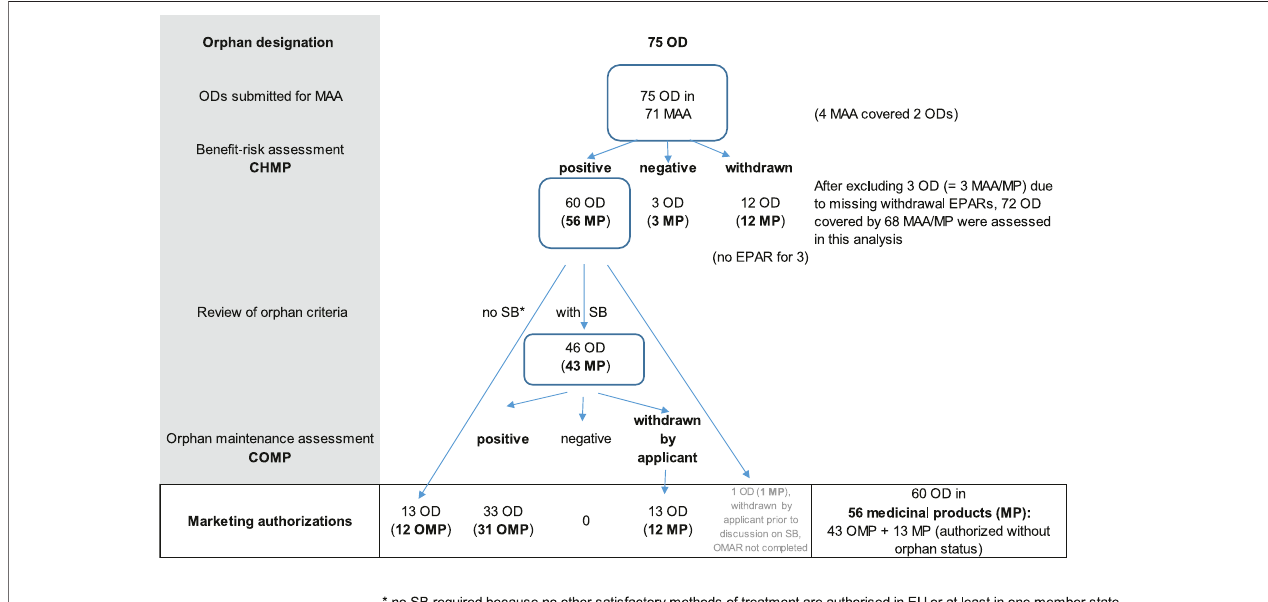
FIGURE 2 | Flow-chart on the regulatory pathway of the sample of ODs assessed for the present analysis. CHMP: Committee for Medicinal Products for Human use; COMP: Committee for Orphan Medicinal products; EPAR: European public assessment report; MA(A): marketing authorization (application), MP: medicinal product; OD: orphan designation; OMAR: orphan maintenance report; OMP: orphan medicinal product; SB: signi fi cant bene fi t.